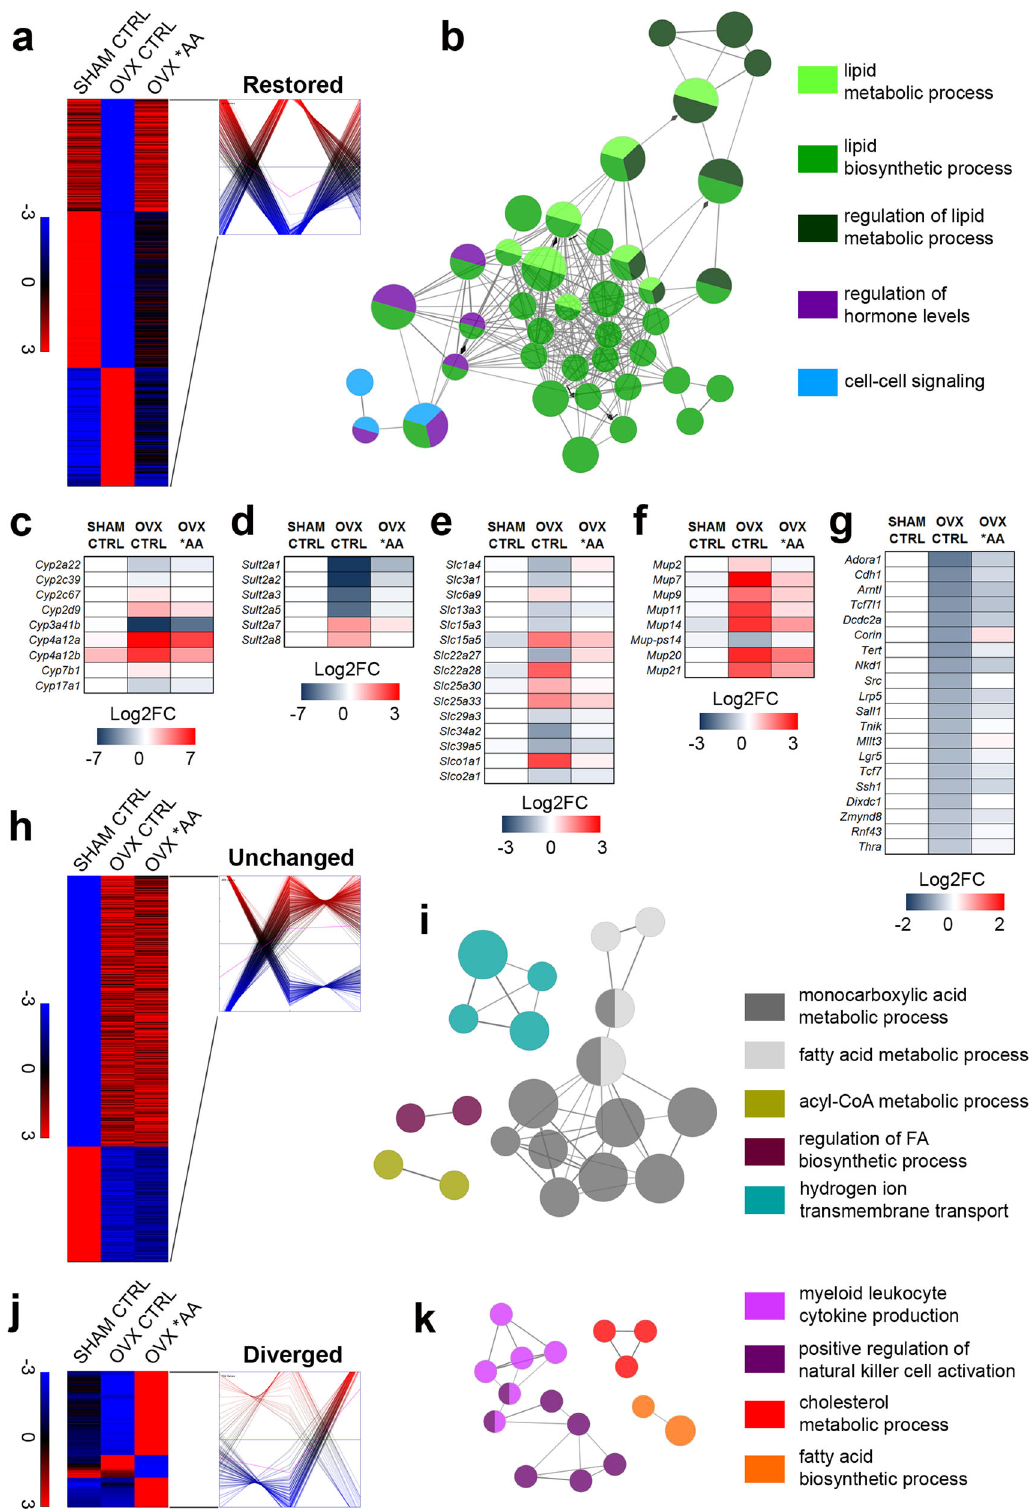
The * AA diet mitigates body weight increase and hepatic lipid deposition consequent to ovariectomy . To further verify the extent to which the changes in gene expression observed in OVX were associated with an overall effect of the * AA diet on mice metabolism, we measured body weight (BW) and lipid content in the liver.